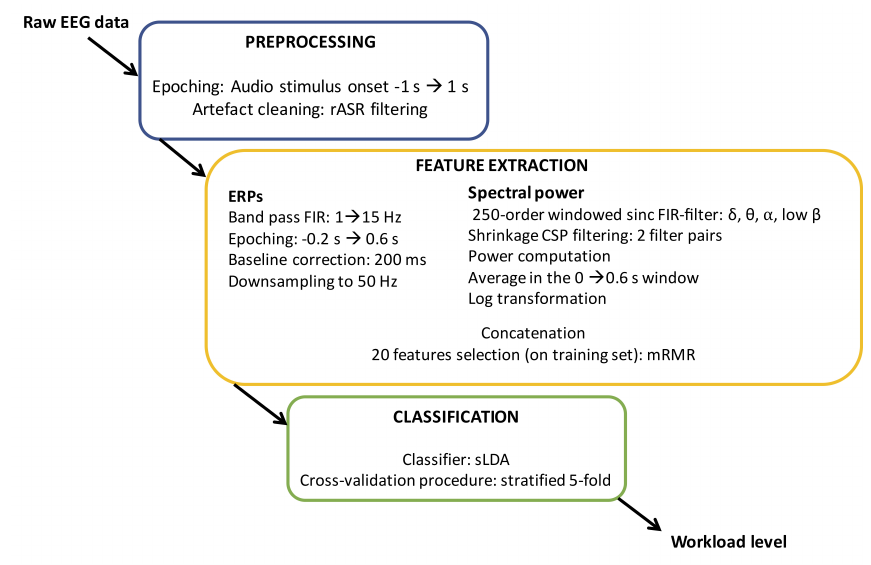
Figure 3. Illustration of the first processing pipeline with ERPs and frequency features. The second pipeline is identical to the first one to the exception that only frequency features were computed over successive and non overlapping epochs of two